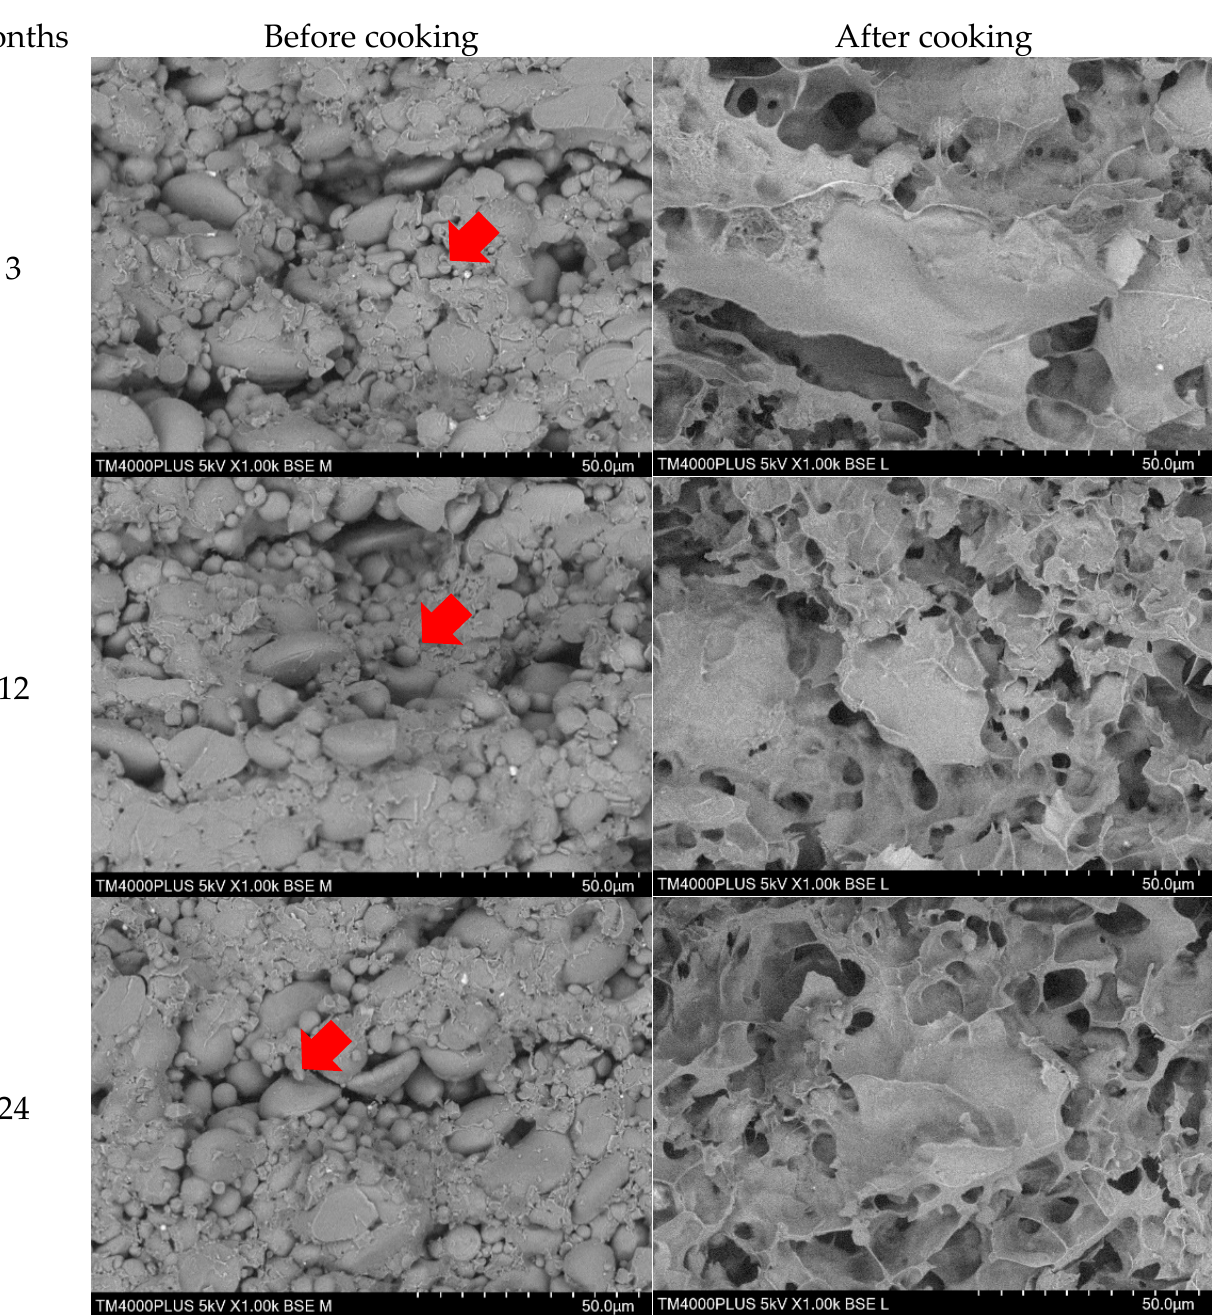
Figure 4. SEM of wheat noodles fortified with isomaltodextrin during different storage periods at 25 °C storage.